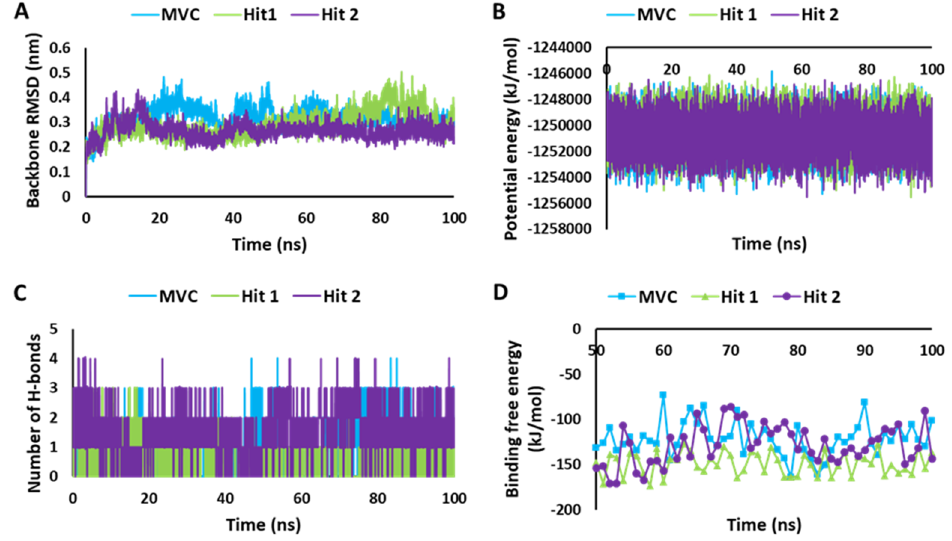
Figure 6. MD simulation analyses. ( A ) RMSD plot. ( B ) Potential energy graph. ( C ) Analysis of hydrogen bonds. ( D ) Calculation of binding free energy for MVC, Hit1, and Hit2, calculated using the MM-PBSA method.